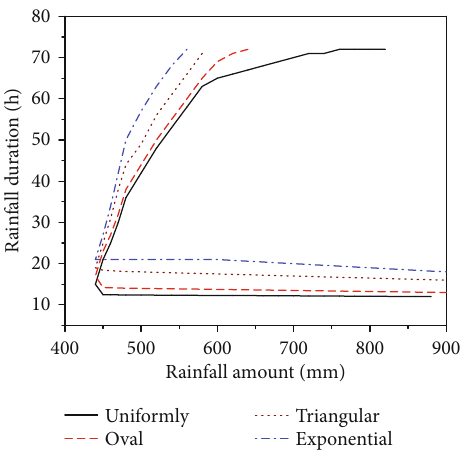
Figure 11: Landslide threshold curve of rainfall-induced slope instability of four root